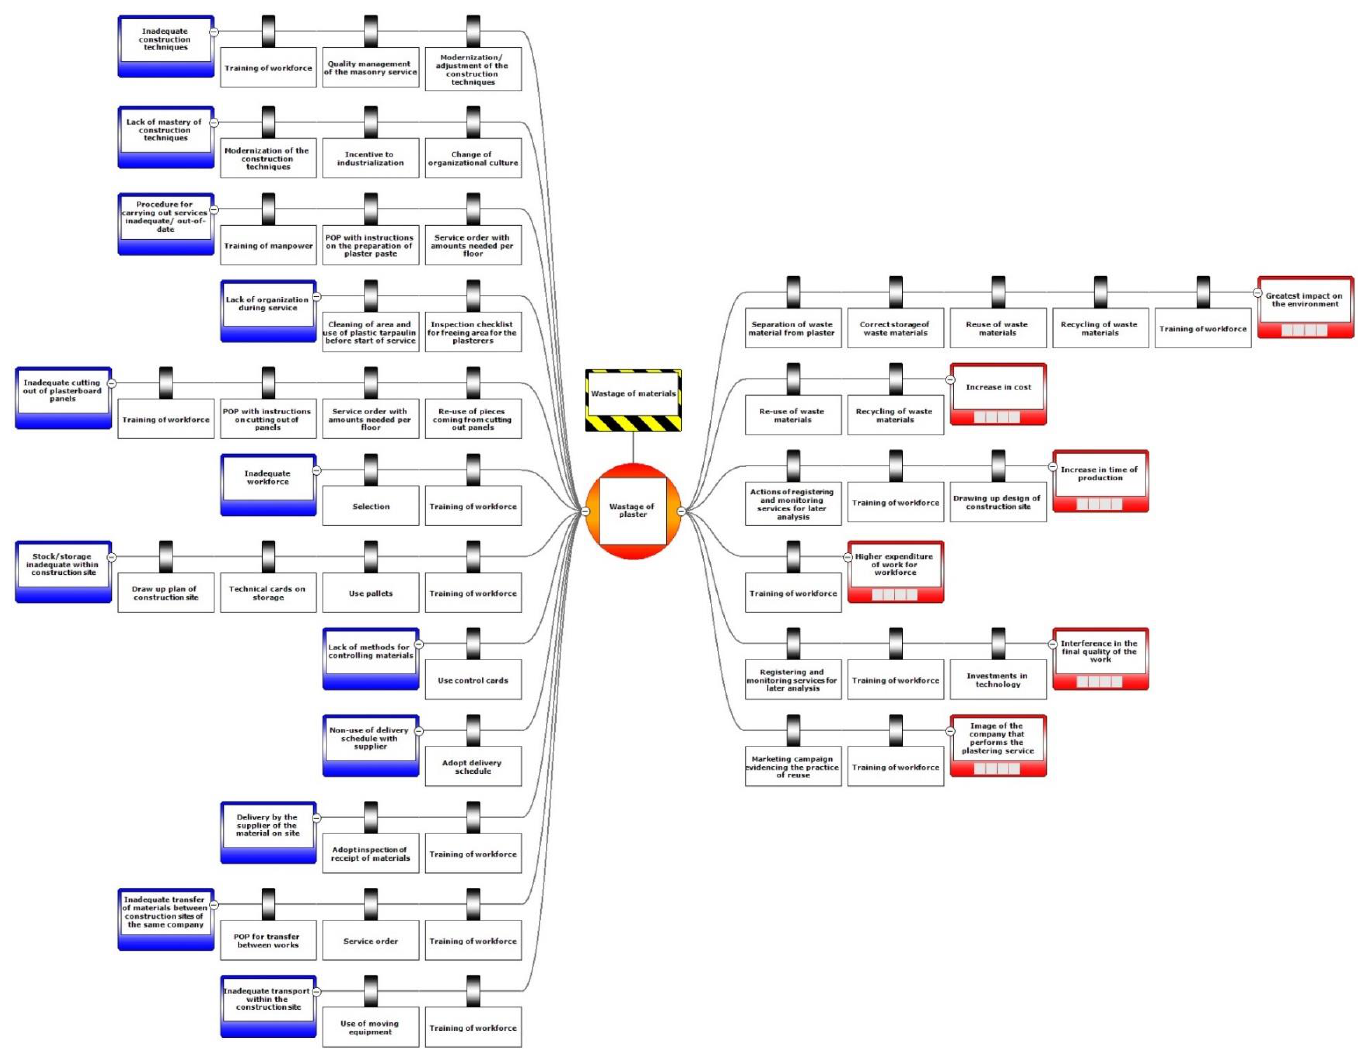
Figure A2. Bow-tie diagram for wastage of plaster.